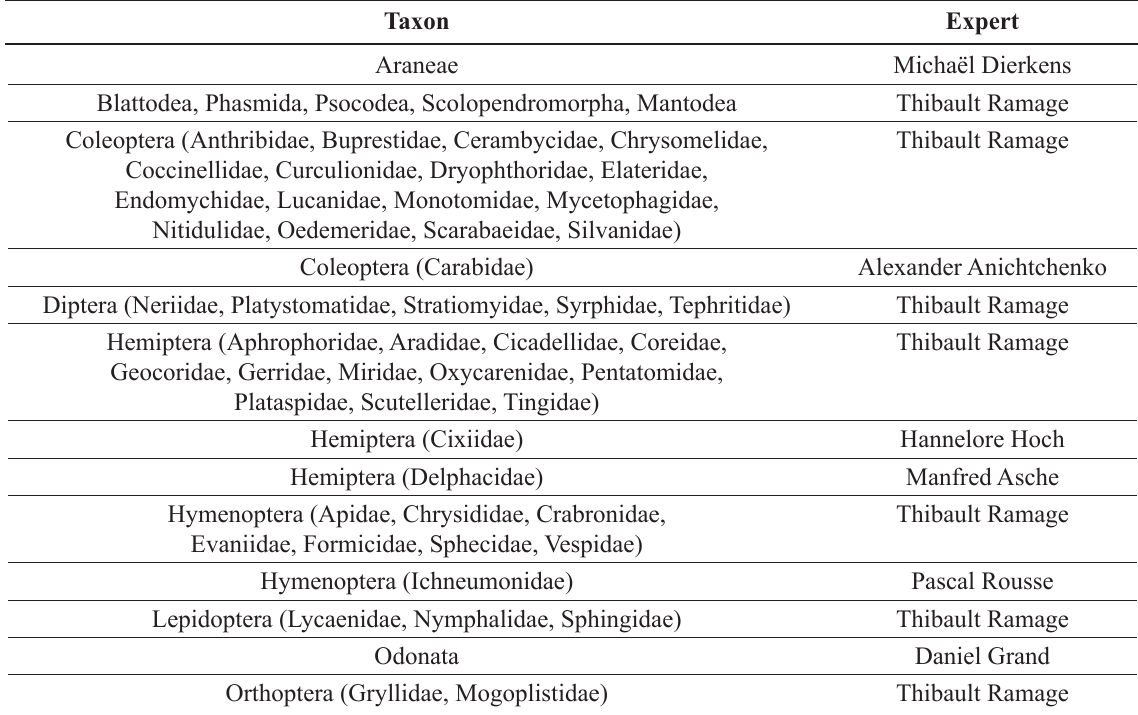
Table 1. Taxa that have been identified on the basis of morphology. For these groups, names of previously described species were used and new species are being